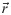
Directed acyclic graph demonstrating the Bayesian state-space model (SSM) approach developed in this paper.The unobserved position r→ at time step n is generated following a combination of movement parameters (the process model) of the fish: r→H (position of the center of the home range), k and radius, and depends in the previous position r→ at n-1. The observed data (number of detection, ND) at time step n consists in the number of detections over n by each of the omnidirectional receivers (j in R). Note that ND at n is independent of the ND at n-1 and is generated using the probability of detection by receiver j at n time unit (PDj,n) determined by a logit function (with parameters α and β at the n time) of the distance (d at n) between the (unobserved) fish position and the (known) receiver position at the n time (observational model). The parameters of the state-space model (movement parameters) were estimated using a Bayesian approach.